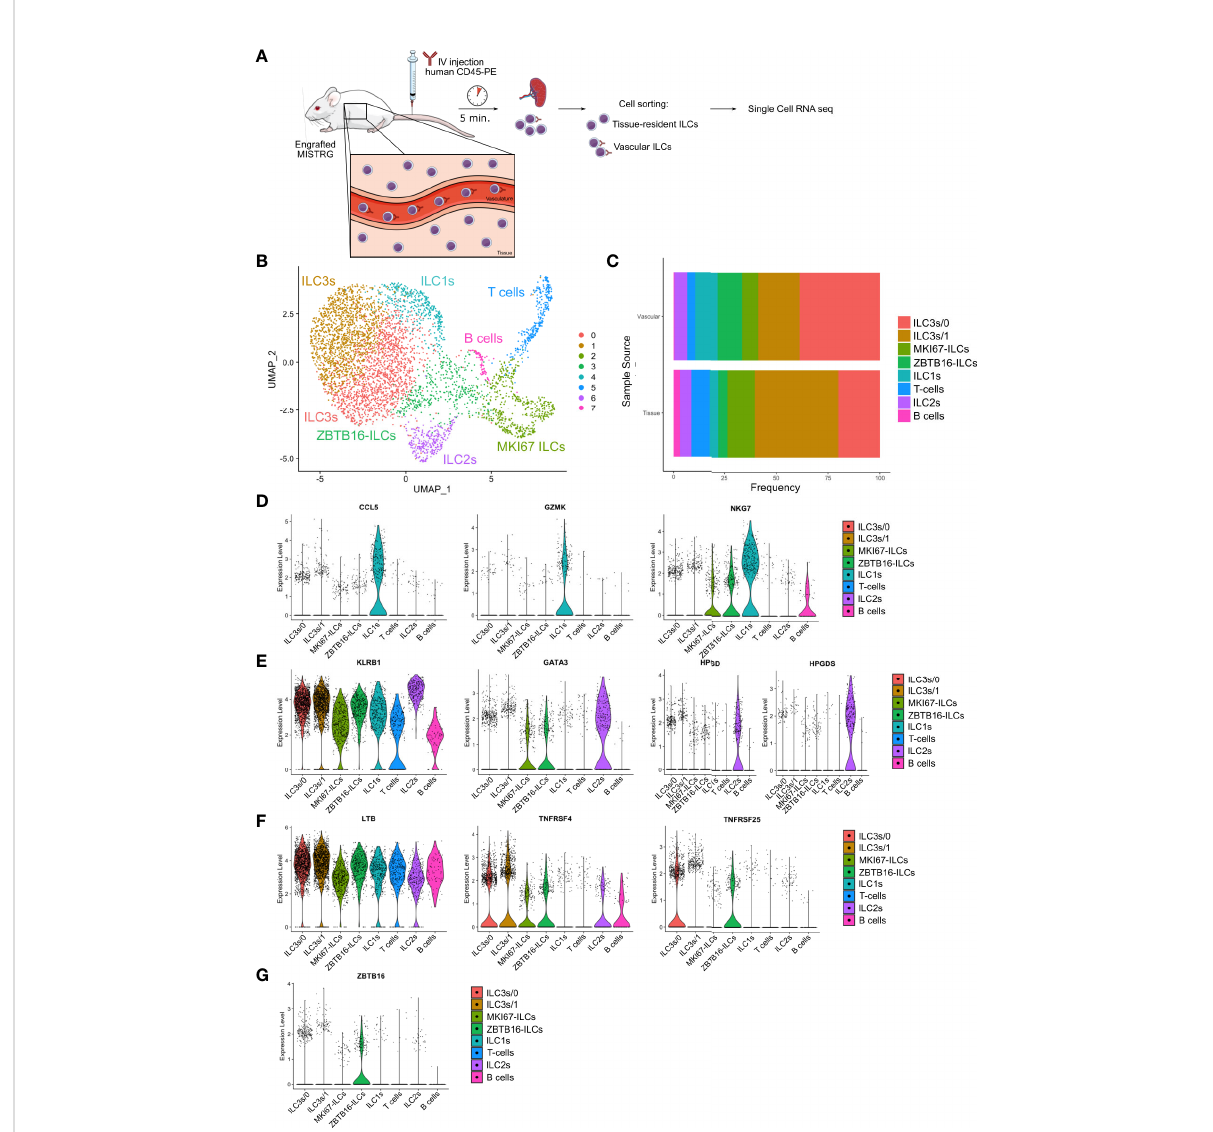
FIGURE 7 Heterogeneity of vascular and tissue ILCs in the spleen de fi ned by single-cell RNA-sequencing. (A) Experimental outline. Human CD127 + CD94 - ILCs were puri fi ed from both the intravascular and the extravascular (tissue) compartment of the spleen of HSPC-engrafted MISTRG mice and subjected to single-cell RNA-sequencing. (B) UMAP depicting human ILC clusters (4,935 cells) in the spleen of HSPC-engrafted MISTRG mice. (C) Frequency of ILC clusters within the vascular versus the tissue compartment of the spleen. (D – G) Violin plots showing expression of selected genes characteristic of ILC1 (D) , ILC2 (E) , ILC3 (F) , and ZBTB16 -ILC (G) clusters. Data are from one single-cell RNA-sequencing experiment with spleen cells pooled from ten MISTRG mice engrafted with three pooled batches of human CD34 + cells. (A) was created with Mind the